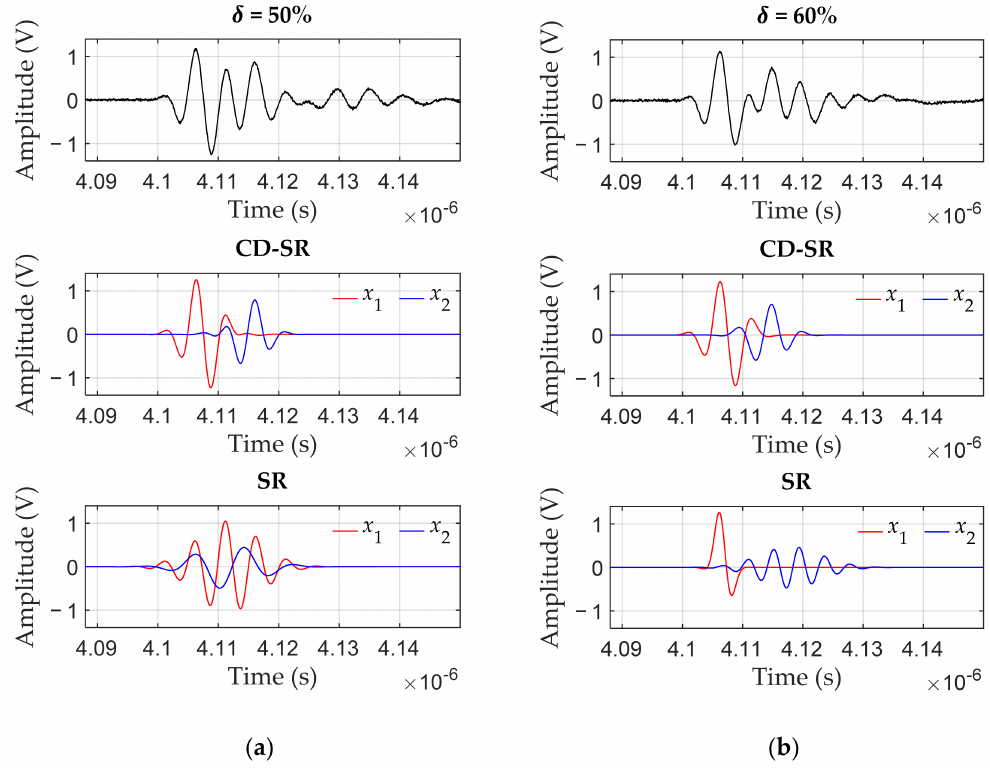
Figure 16. Comparison of reconstructed echoes: ( a ) δ = 50%; ( b ) δ =